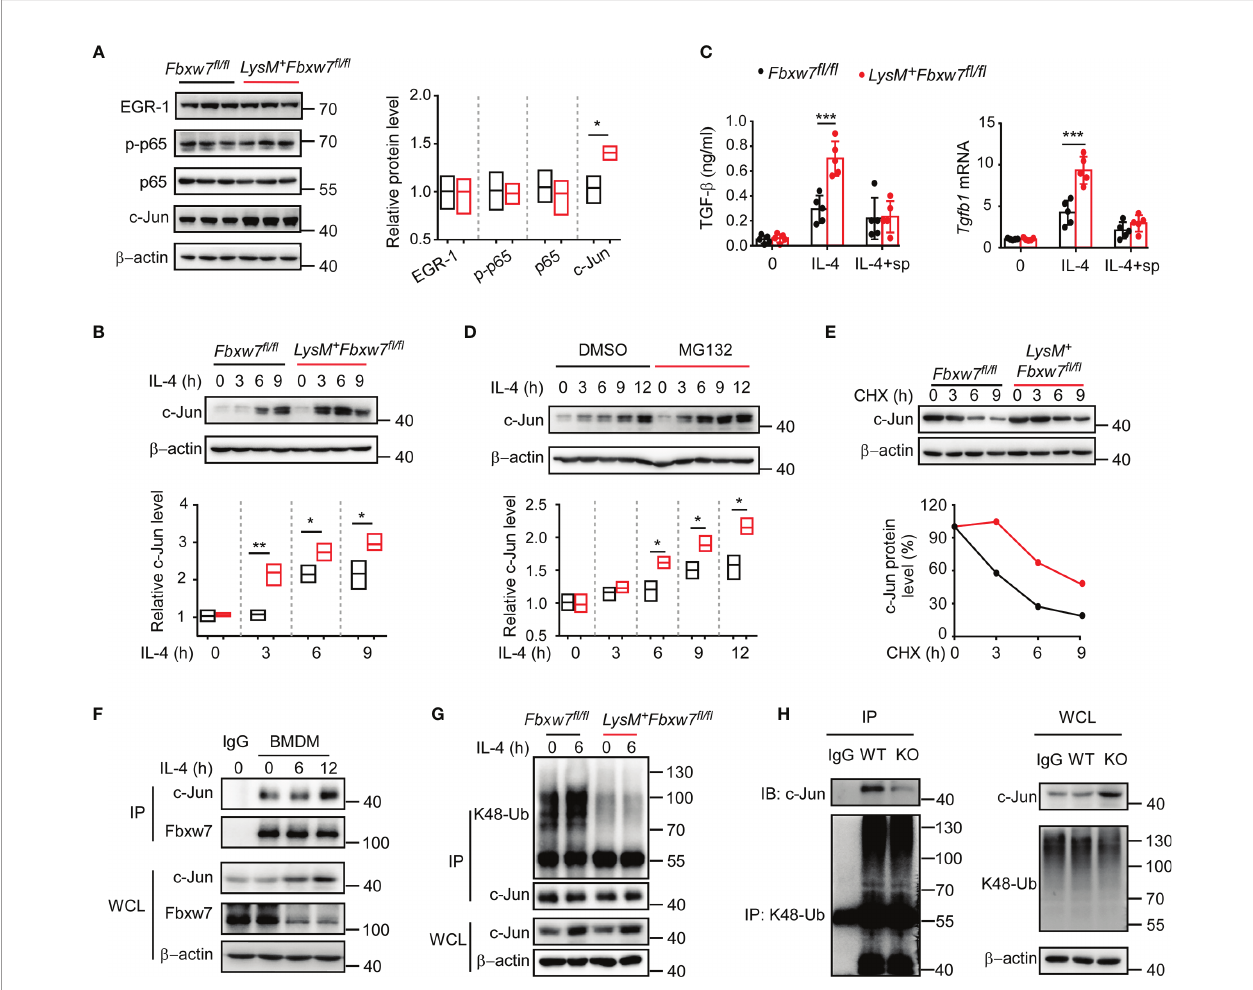
FIGURE 5 | Fbxw7 regulates TGF- b expression via mediating the ubiquitination of c-Jun. (A) Immunoblot analysis of phosphorylated and/or total proteins in lysates of lung tissues obtained from bleomycin-treated Fbxw7 fl / fl and LysM + Fbxw7 fl / fl mice. Densitometric fold change of target proteins based on Fbxw7 fl / fl group was calculated. (B) Immunoblot analysis of c-Jun protein levels in lysates of IL-4 (30 ng/ml) stimulated BMDMs from Fbxw7 fl / fl and LysM + Fbxw7 fl / fl mice. Densitometric fold change for the relative c-Jun level based on Fbxw7 fl / fl untreated group was calculated. (C) Fbxw7 fl / fl and LysM + Fbxw7 fl / fl BMDMs stimulated with IL-4 and treated or not with SP600125 (15 m M), qRT-PCR analysis for Tgfb1 relative mRNA expression and ELISA for TGF- b protein expression. Data are expressed as mean ± SD of biological duplicates (n=5) and are the representative of three independent experiments. P values were obtained using two-tailed Student ’ s t test, *** P < 0.001. (D) Immunoblot analysis of c-Jun expression in BMDMs treated or not with MG132 (20 m M) for 8 hours and stimulated with IL-4 for the indicated durations. Densitometric fold change of c-Jun based on IL-4, MG132 untreated group was calculated. (E) Immunoblot analysis and relative protein levels of c-Jun in lysates of Fbxw7 fl / fl and LysM + Fbxw7 fl / fl BMDMs treated with CHX (40 m g/ml) for indicated hours after stimulation with IL-4 for 6 h. (F) Coimmunoprecipitation and immunoblot with IL-4 for 6 h. (H) Peritoneal macrophages from LysM + Fbxw7 fl / fl (WT) and Fbxw7 fl / fl (KO) mice were stimulated with IL-4 for 6 h, coimmunoprecipitation